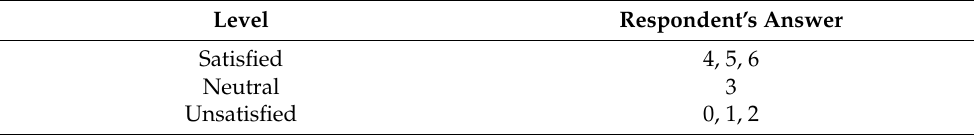
Table 1. Levels of